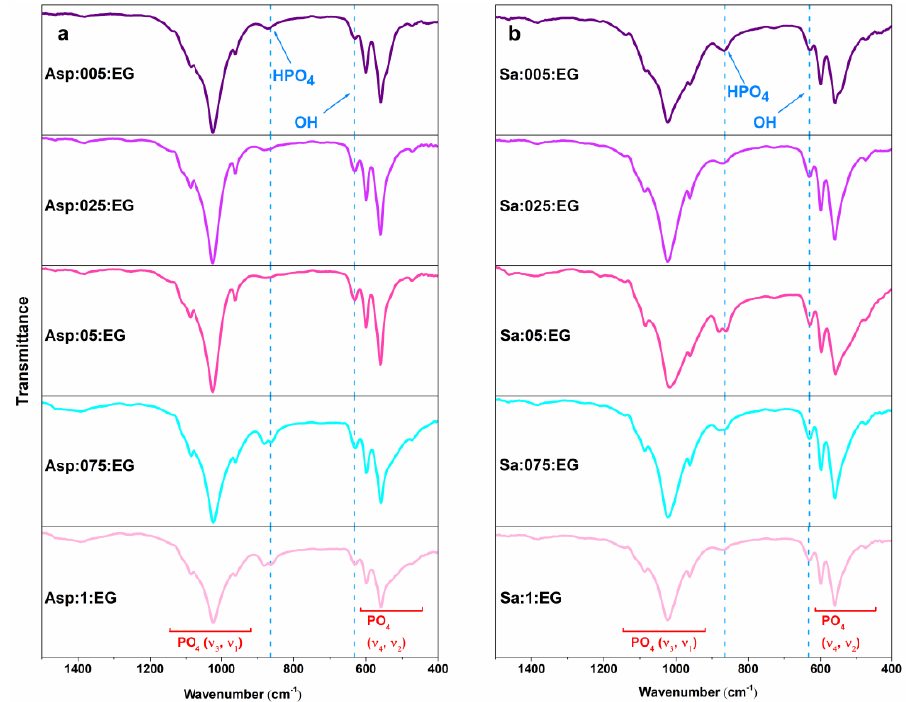
Figure 5. FTIR spectra of the samples prepared using various concentrations of DL-aspartic ( a ) and suberic ( b ) acids in water – ethylene glycol mixture (40:60, v/v ) after a solvothermal treatment at suberic ( b ) acids in water–ethylene glycol mixture (40:60, v / v ) after a solvothermal treatment at 200 °C for 5 h. 200 ◦ C for 5